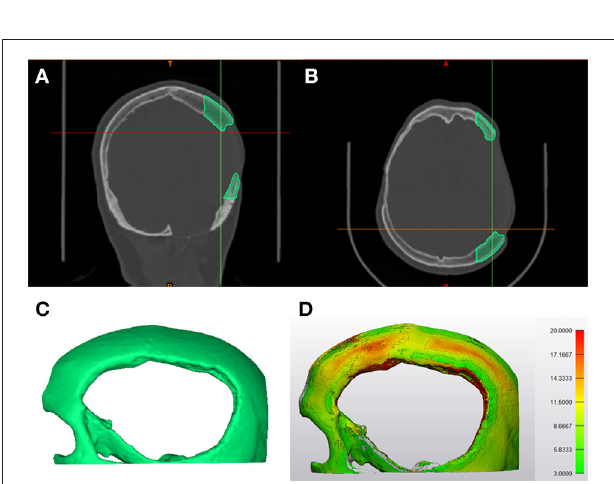
FIGURE 4 | Steps involved in the generation of topographic bone thickness map. (A) Coronal view representing the bone segmentation (green) of the region of interest in the computed tomography (CT) data. (B) Axial view illustrating the bone segmentation (green) of the region of interest in the computed tomography (CT) data. (C) Profile view of the three-dimensional (3D) volumetric reconstruction of the area of interest. (D) The segmented skull displaying the color-coded topographic bone thickness map